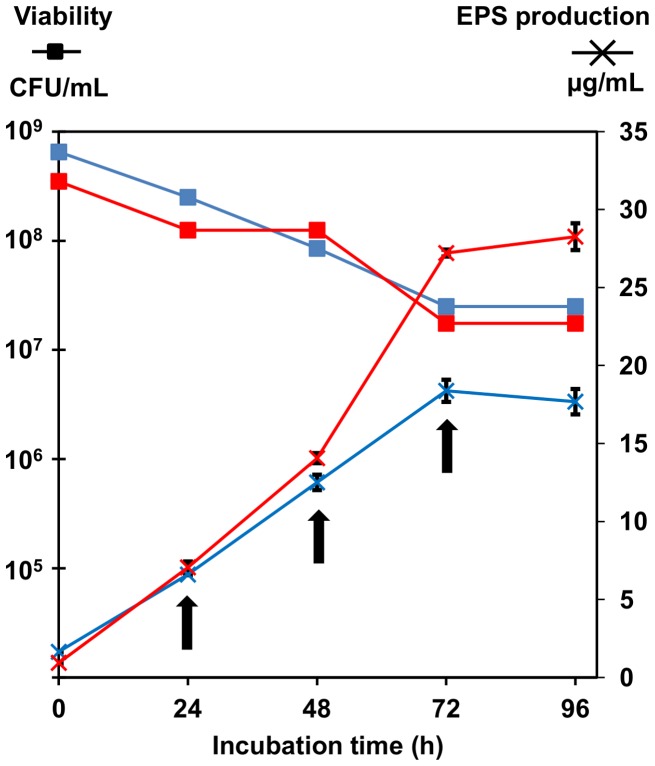
Kinetics of exopolysaccharides secretion and viability of Mmm
 strain Afadé following transfer into CMRL-1066 medium with (red) or without (blue) glucose supplementation.
Glucose (1 g/L) was added at 24, 48 and 72 h (arrows).